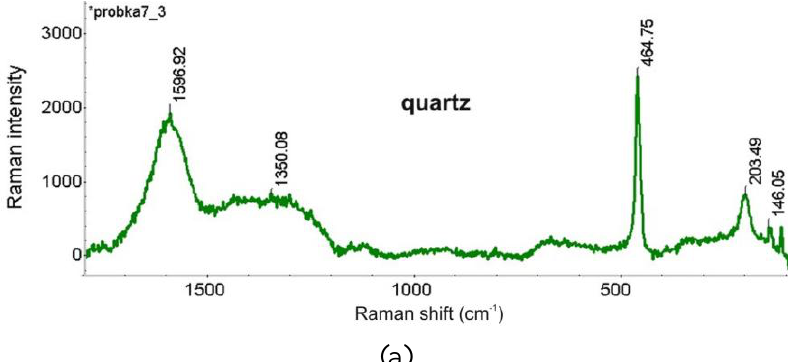
Figure 28. Raman spectra of quartz (a) and cuprite (b), registered on the bronze fibula corrosion